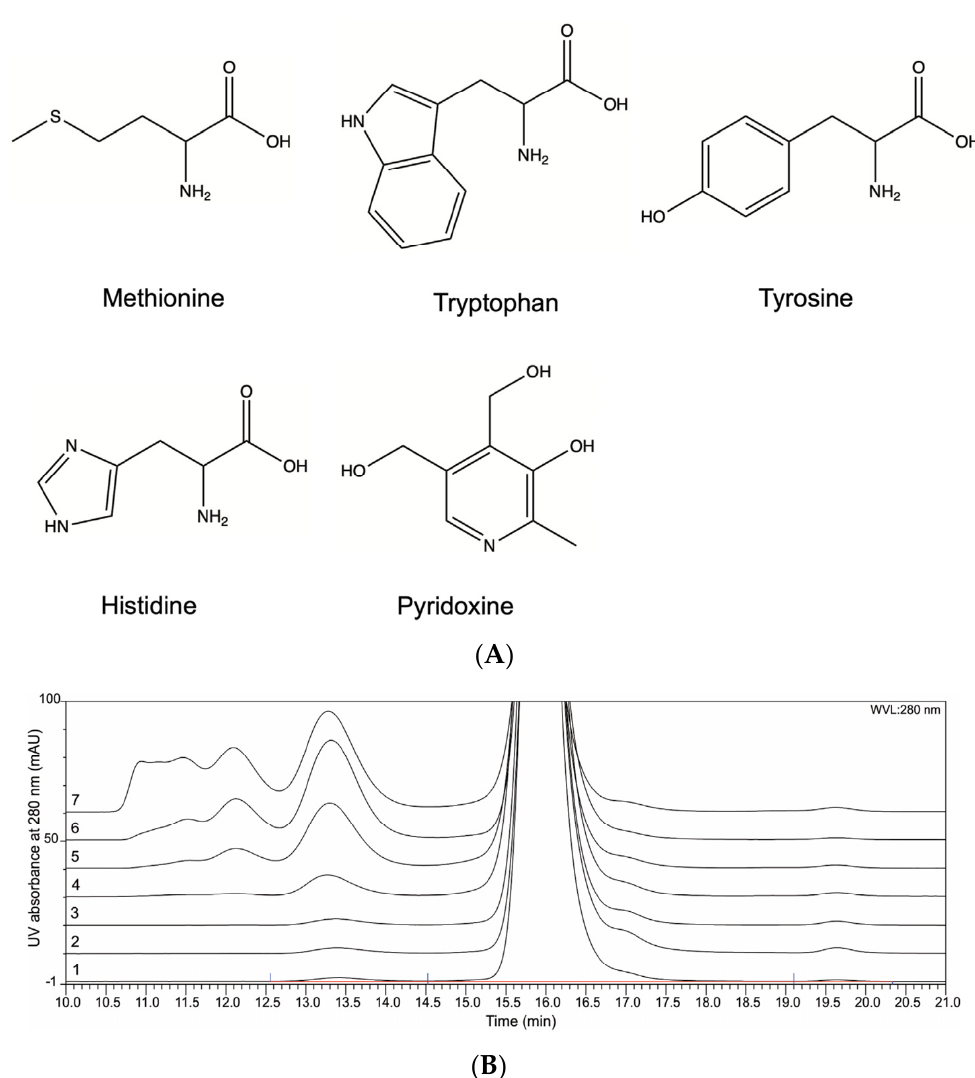
Figure 6. ( A ) Structure of tested aggregation inhibitors. ( B ) Expanded view of mAb1 SEC profiles for excipient screening (except the negative control, all samples contained 1 mM AAPH). Chromatogram 1: negative control sample (no AAPH stressed mAb1); chromatogram 2: sample contained 2 mM Trp; chromatogram 3: sample contained 2 mM pyridoxine; chromatogram 4: sample contained 2 mM Tyr; chromatogram 5: sample contained 2 mM His; chromatogram 6: sample contained 2 mM Met; chromatogram 7: positive control sample (AAPH stressed mAb1). All samples contained 10 mg/mL mAb1 and were incubated at 40 ◦ C for 72 h prior to SEC